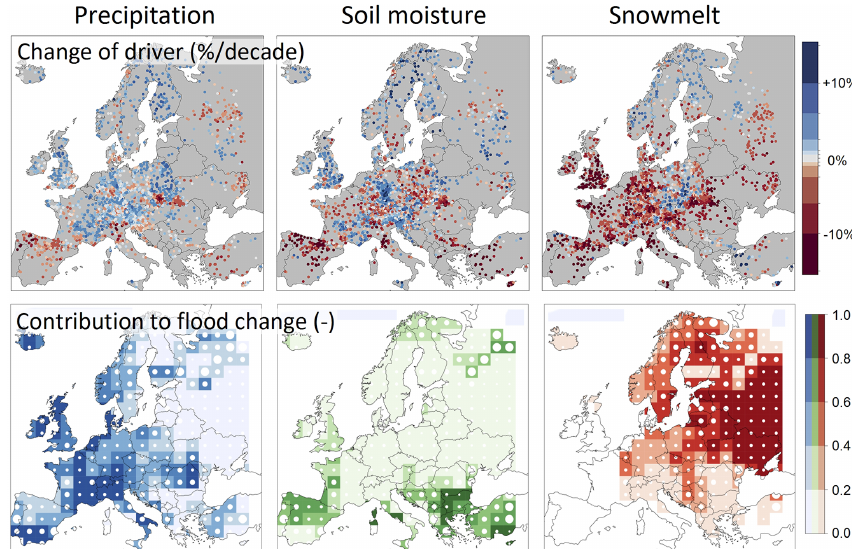
Figure 16. Attribution of observed flood changes at 2370 stations in the period 1960–2010 to their climatic drivers based on Bayesian inference. Top panels: observed trends of 7d maximum annual precipitation, soil moisture and snowmelt. Each point represents a catchment. Blue colours indicate an increasing trend, reddish colours show a decreasing trend. Bottom panels: Attributed contribution to the changes in the 100-year flood for precipitation, soil moisture and snowmelt. Strength of colour shows the relative contribution. For example, a value of 0.5 indicates that half of the observed flood trend is due to that driver. White circles indicate the reliability of the attribution, with small circles referring to a more reliable attribution (Bertola et al.,